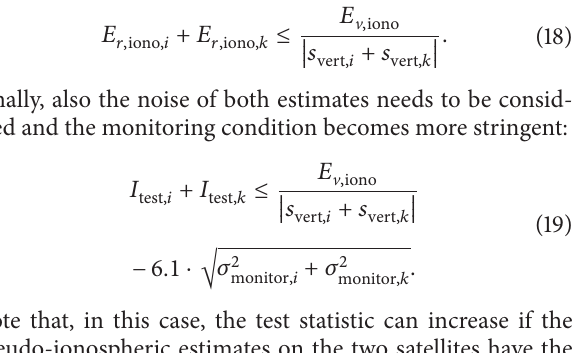
pseudorange errors for the affected satellites 𝑖 and 𝑘 , using (15), then